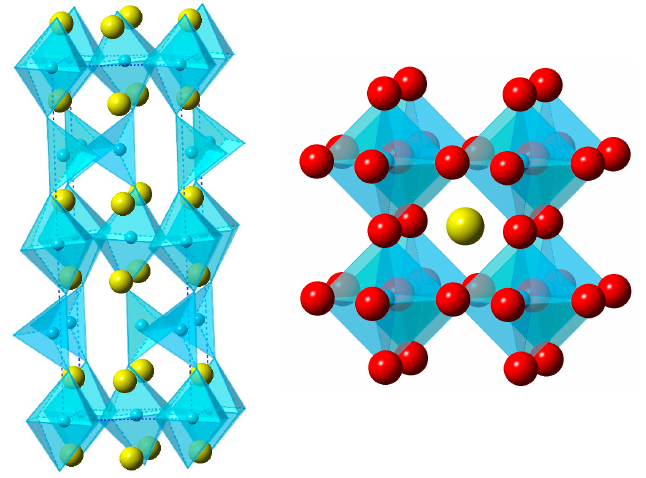
Figure 1. Structure of Sr 2 Fe 2 O 5 (showing oxygen vacancy ordering) ( left ) and SrFeO 3 ( right ).